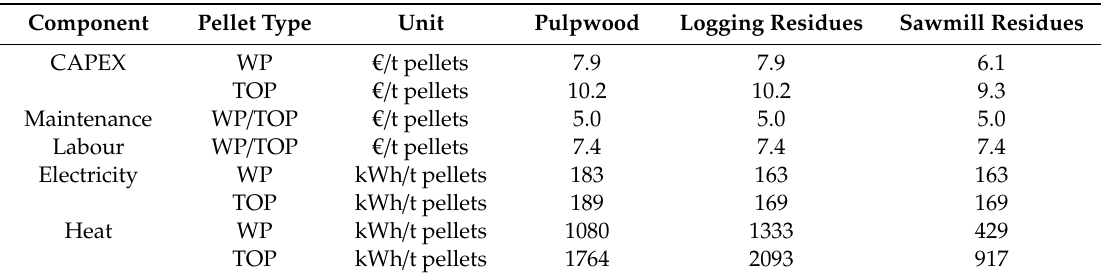
Table 2. Base costs factors of CAPEX and OPEX costs for the United States, in € / t pellets, for a 500 kt / y pellet plant, based on data from